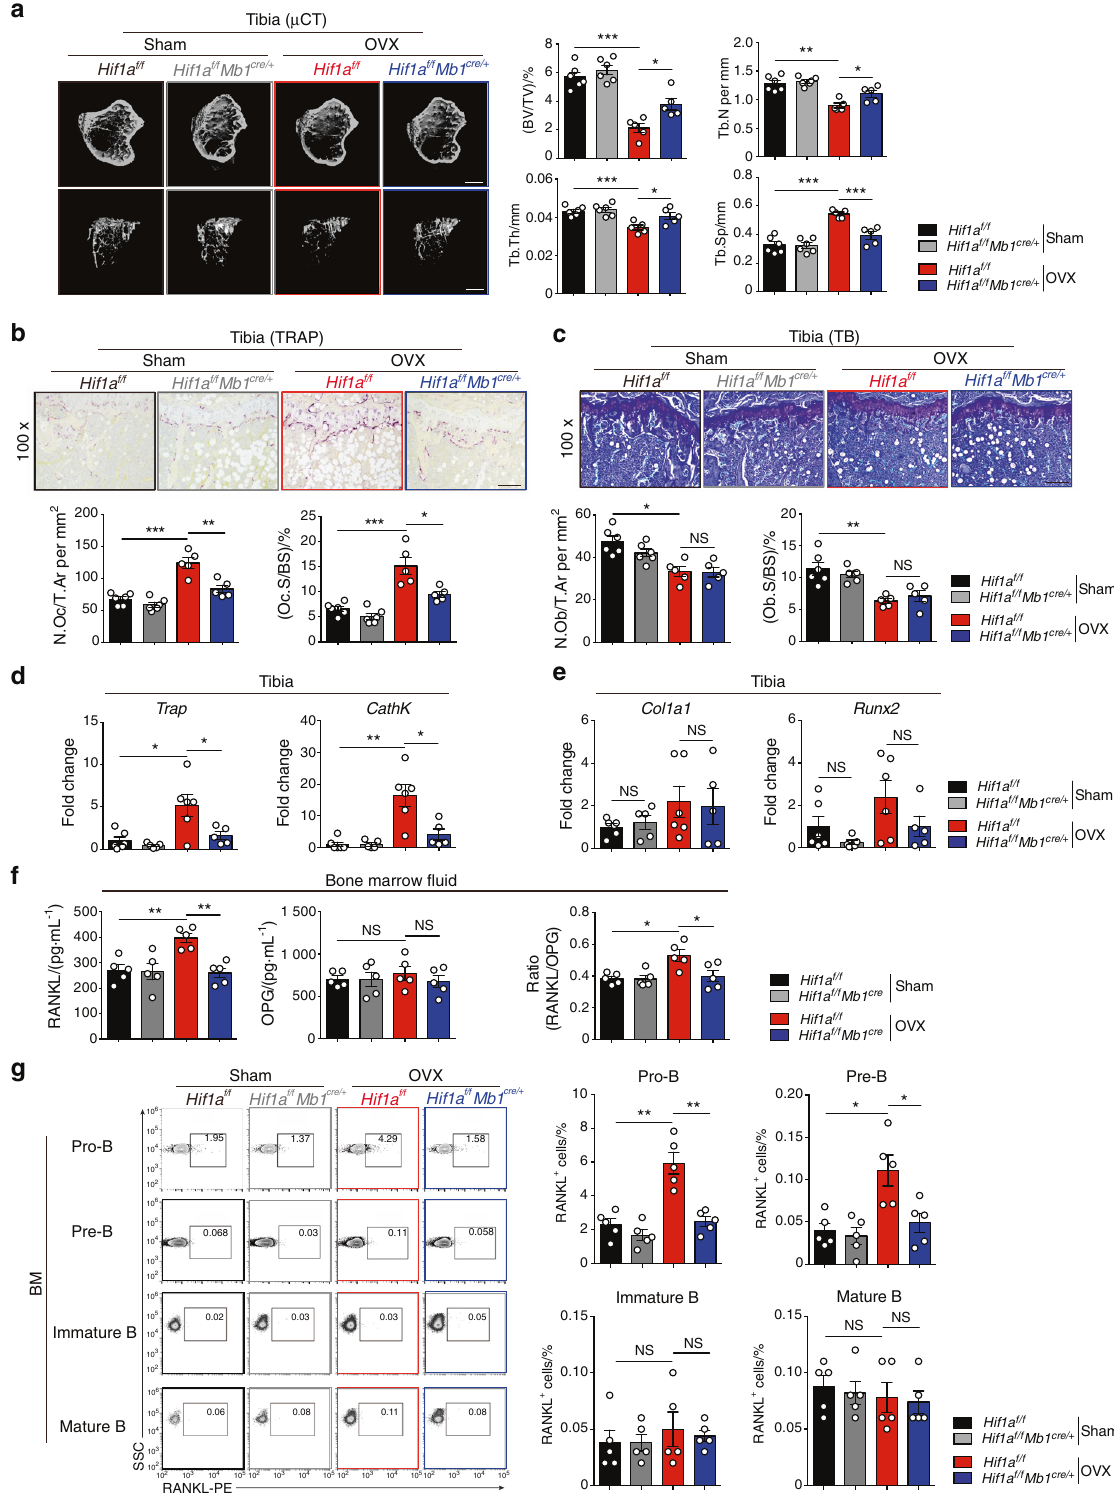
Fig. 3 Loss of HIF-1 α in B cells partially inhibits ovariectomy-induced bone loss through RANKL-mediated osteoclastogenesis. a Representative μ CT images of tibial trabecular bone and structural parameters (BV/TV, Tb.N, Tb.Th, Tb.Sp) in sham-operated (Sham) and ovariectomized (OVX) Hif1a f/f Mb1 cre/ + mice and Hif1a f/f littermate control mice ( n = 5, 6). Scale bars, 500 μ m. Representative TRAP staining ( b ) and TB staining ( c ) in tibia from mice shown in ( a ). Bone resorption parameters (N.Oc/T.Ar, Oc.S/BS) and bone formation parameters (N.Ob/T.Ar, Ob.S/BS) in metaphyseal regions of the tibia were assessed by histomorphometric analyses. Scale bars, 100 μ m. Trap , CathK ( d ), Col1a1 and Runx2 ( e ) mRNA expression in bone from mice shown in ( a ). f RANKL and OPG levels and the RANKL/OPG ratio in bone marrow fl uid from mice shown in ( a ). g Representative plots and frequencies of RANKL + cells in B cell subpopulations from mice as in ( a ). * P < 0.05, ** P < 0.01, *** P <